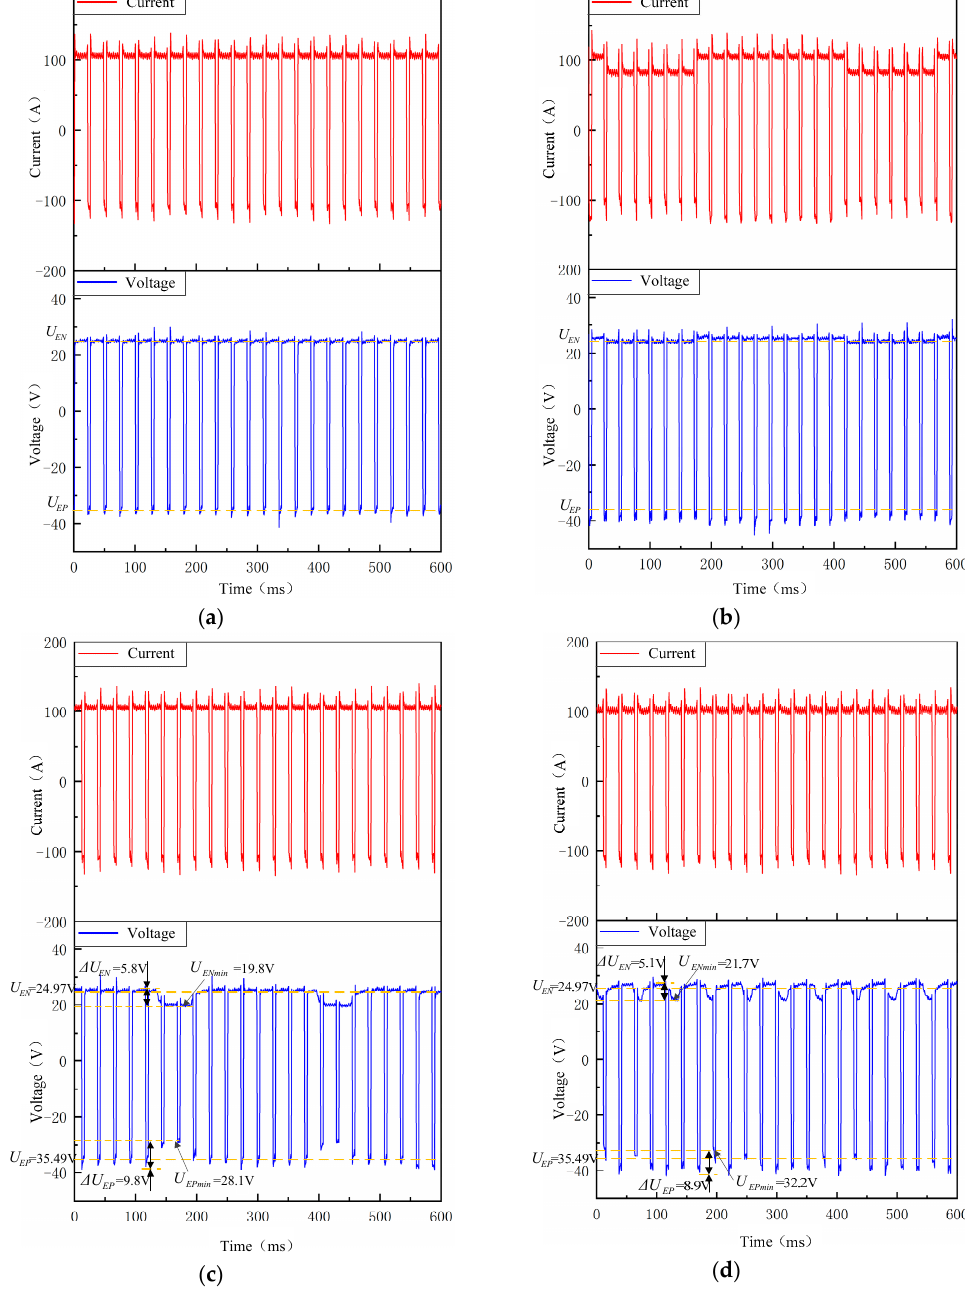
Figure 4. Welding current–voltage synchronizing wave form. ( a ) VPPAW; ( b ) DP-VPPAW; ( c ) PPG-VPPAW (4 Hz); ( d ) PPG-VPPAW (20 Hz).